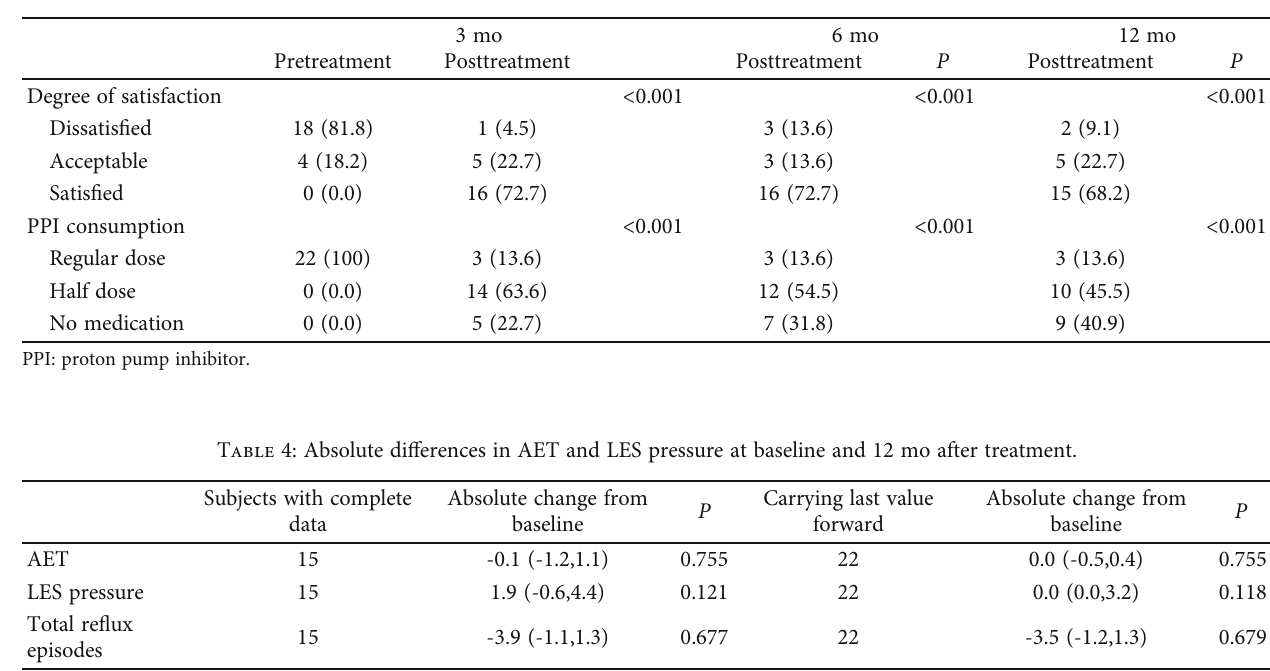
Figure 4: Symptoms ’ changes after radiofrequency procedure. Signi fi cant reductions in symptom scores (heartburn, regurgitation, and chest pain) at 3 months, 6 months, and 12 months. Table 3: Degree of satisfaction with life quality and PPI consumption before and after treatment.